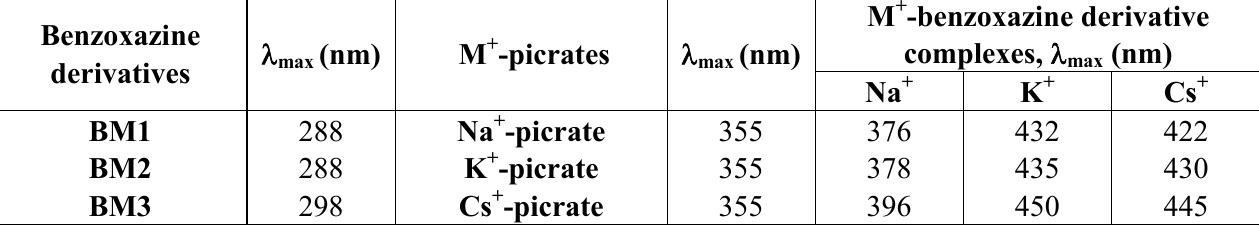
Table 1. Maximum absorption peaks of benzoxazine derivatives, alkali – picrates, and alkali metal ion - benzoxazine